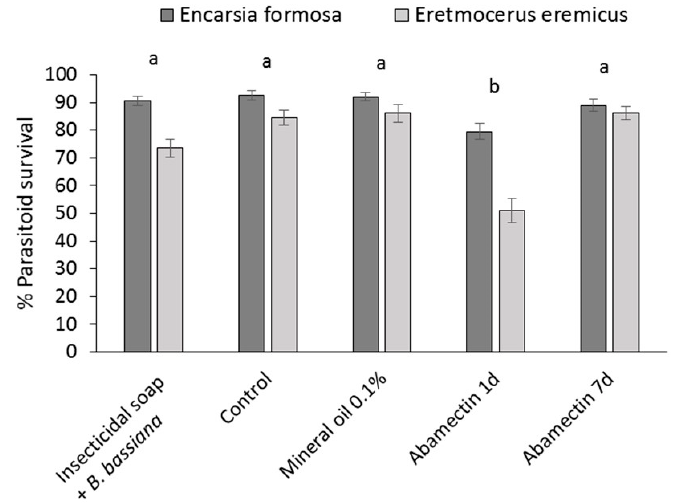
Figure 5. Effect of residues of selected reduced risk and biopesticide products and a pesticide control (Abamectin) on survival of whitefly parasitoids Encarsia formosa and Eretmocerus eremicus (mean ± SE). Different letters indicate significant differences among products ( α = 0.05). Survival of E. eremicus was always significantly lower than E. formosa ( α = 0.05).